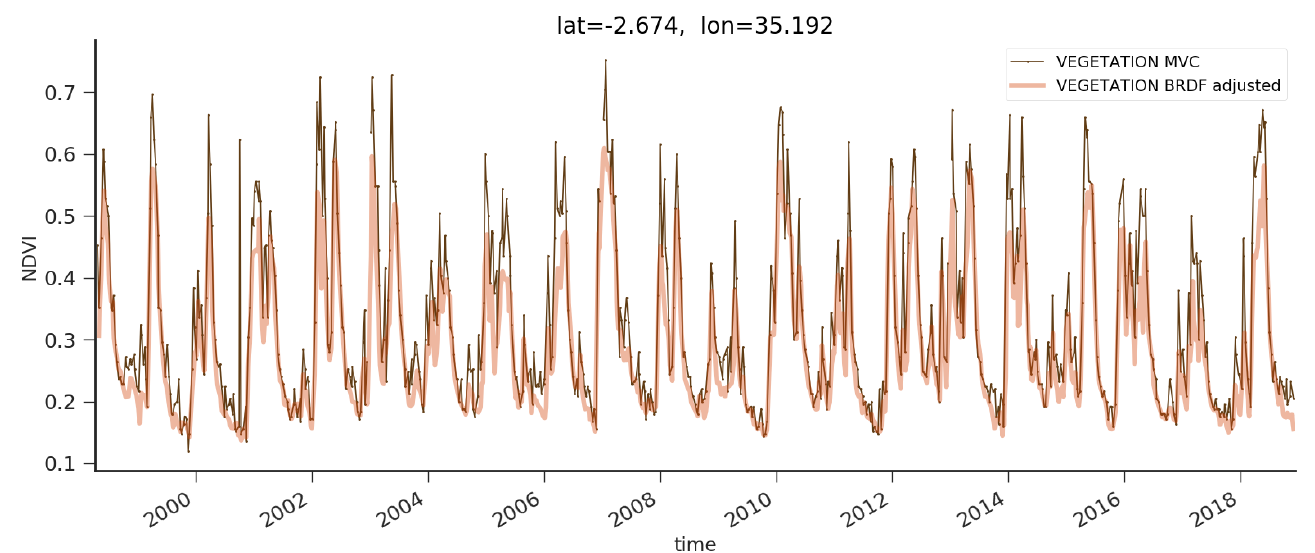
Figure 5. Temporal evolution of the NDVI profile of Belmanip 151 site (Tanzania, see coordinates at top of Figure) over a period of 20 years.VEGETATION MVC NDVI and BRDF-adjusted NDVI datasets are displayed in dark (thin) and red (thick-solid) lines. To avoid clutter and enhance clarity, uncertainties associated with BRDF-adjusted NDVI are left out.